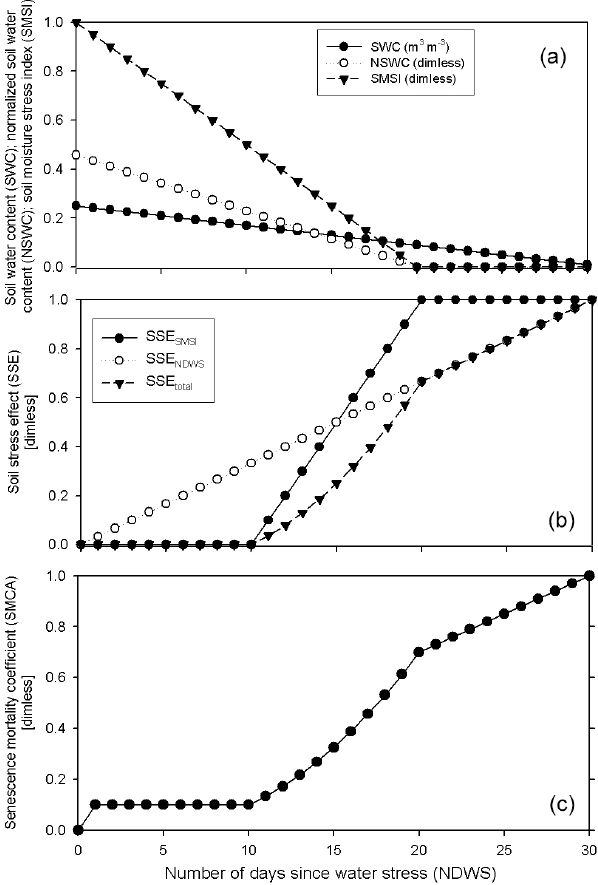
Figure 3. Demonstration of the senescence calculation with an ex- ample. (a) Soil water content (SWC; black dots), normalized soil water content (NSWC; white dots) and soil moisture stress index (SMSI; black triangles) during 30 days of a hypothetical drought event. (b) Soil stress effect based on soil moisture stress index (SSE SMSI ; black dots), soil stress effect based on number of days since water stress (SSE NDWS ) and total soil stress effect (SSE total ) . (c) Aboveground senescence mortality coefficient